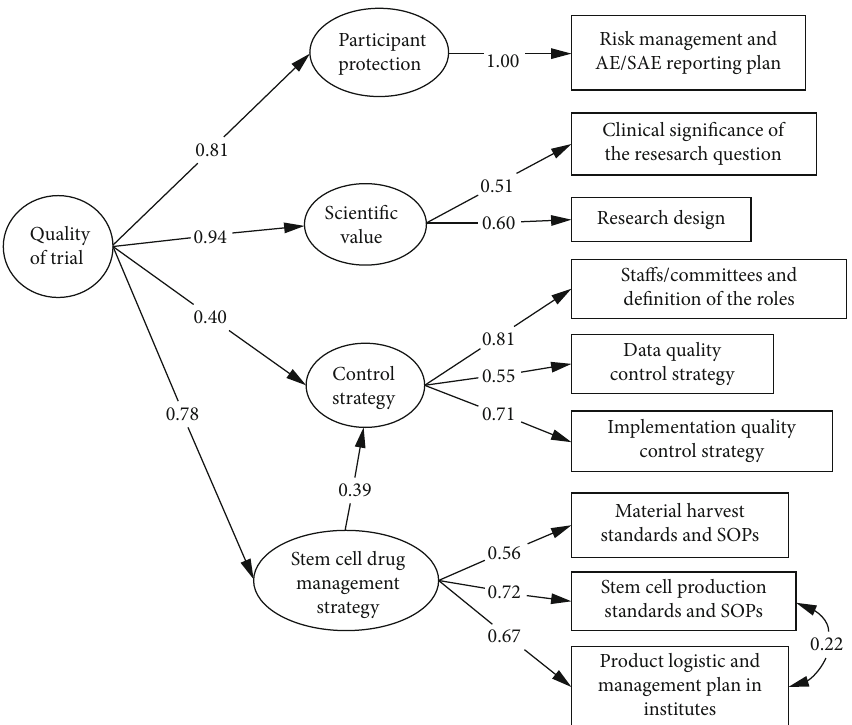
Figure 4: Structural equation modeling (SEM) of key indicators to the quality of stem cell trials. Table 2: Validation of quality assessment tool of stem cell clinical trials by structural equation modeling. Quality